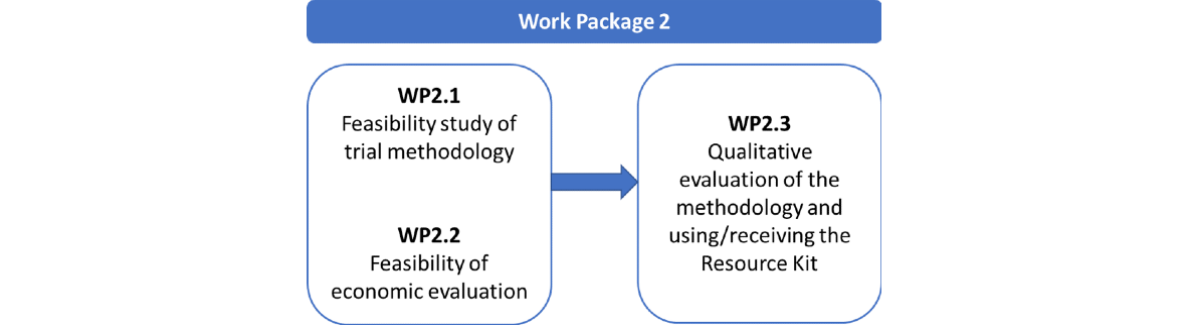
Figure 1. Design and components of